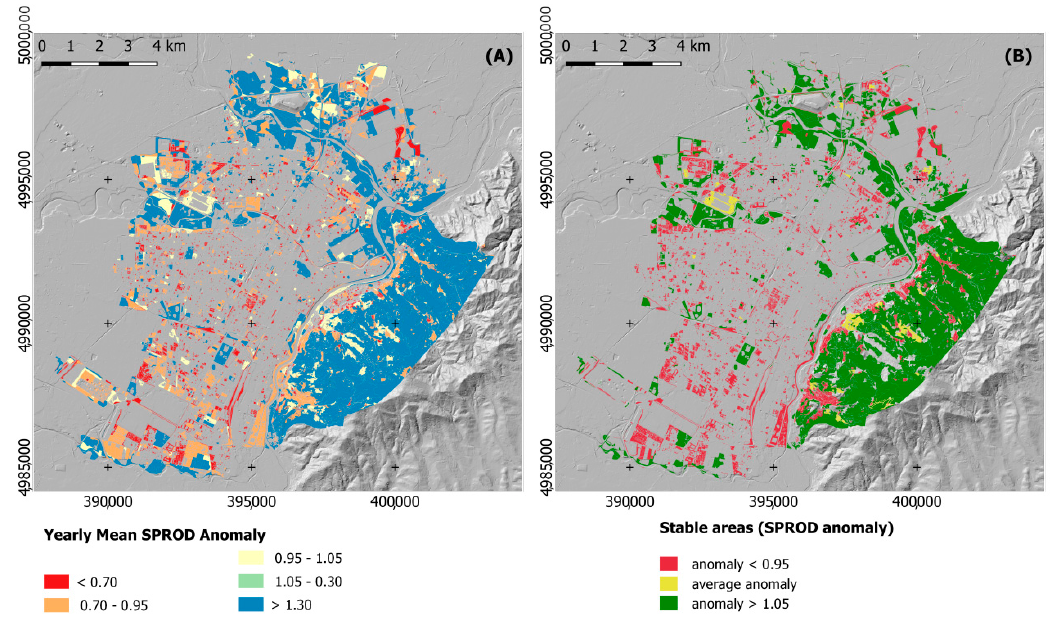
Figure 7. ( A ) Spatial distribution of the 3-year average SPROD anomaly over Torino. Anomaly is computed according to Equation (3). Five classes were mapped: one mapping areas showing an average SPROD value smaller than 70% of the average one (<0.7); one mapping areas showing an average SPROD value smaller down to 70% of the average one (0.7–0.95); one mapping areas showing a SPROD value (0.95–1.05) comprised in the range “average SPROD ” ± 5%; one mapping areas showing an average SPROD value up to 70% higher than the average one (1.05–1.3); and one mapping areas showing an average SPROD value more than 70% higher than the average one (>1.3). ( B ) Map showing areas that, in the three investigated years, always behaved similarly in term of LOS anomaly (averagely shorter, equal, or longer then the yearly mean SPROD of the area). Reference frame is WGS84 UTM 32N.